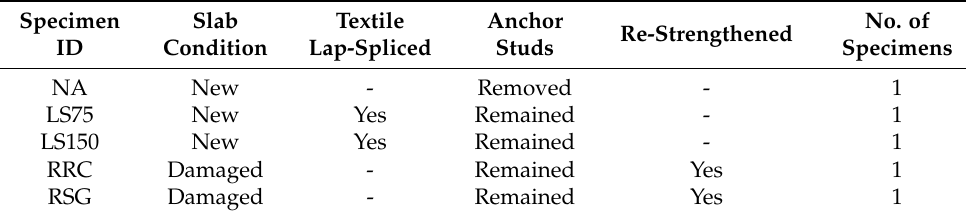
Table 6. Characteristic of TRC-strengthened slab specimens for flexural test.